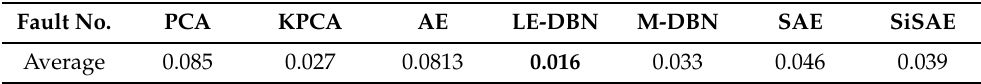
Table 2. Average False Detection Rate for All Faults in the TE Process. Fault No.